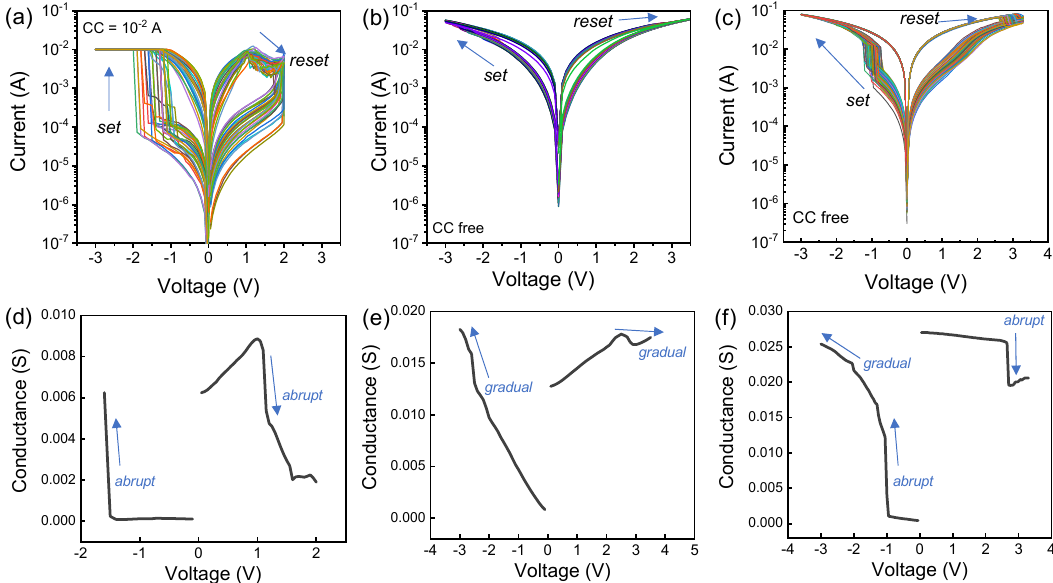
Figure 2. I-V characteristics of the TaO x / HfO 2 memristor: ( a ) Non-volatile filamentary switching with Figure 2. I ‐ V characteristics of the TaO x /HfO 2 memristor: ( a ) Non ‐ volatile filamentary switching with compliance current (CC) = 10 mA; ( b ) non-volatile interface switching without CC; ( c ) non-volatile compliance current (CC) = 10 mA; ( b ) non ‐ volatile interface switching without CC; ( c ) non ‐ volatile pseudo-interface switching without CC; Conductance-voltage (G-V) characteristics of the TaO x / HfO 2 pseudo ‐ interface switching without CC; Conductance ‐ voltage (G ‐ V) characteristics of the TaO x /HfO 2 memristor. ( d ) non-volatile filamentary switching with CC = 10 mA; ( e ) non-volatile interface switching memristor. ( d ) non ‐ volatile filamentary switching with CC = 10 mA; ( e ) non ‐ volatile interface without CC; ( f ) non-volatile pseudo-interface switching without switching without CC; ( f ) non ‐ volatile pseudo ‐ interface switching without CC.